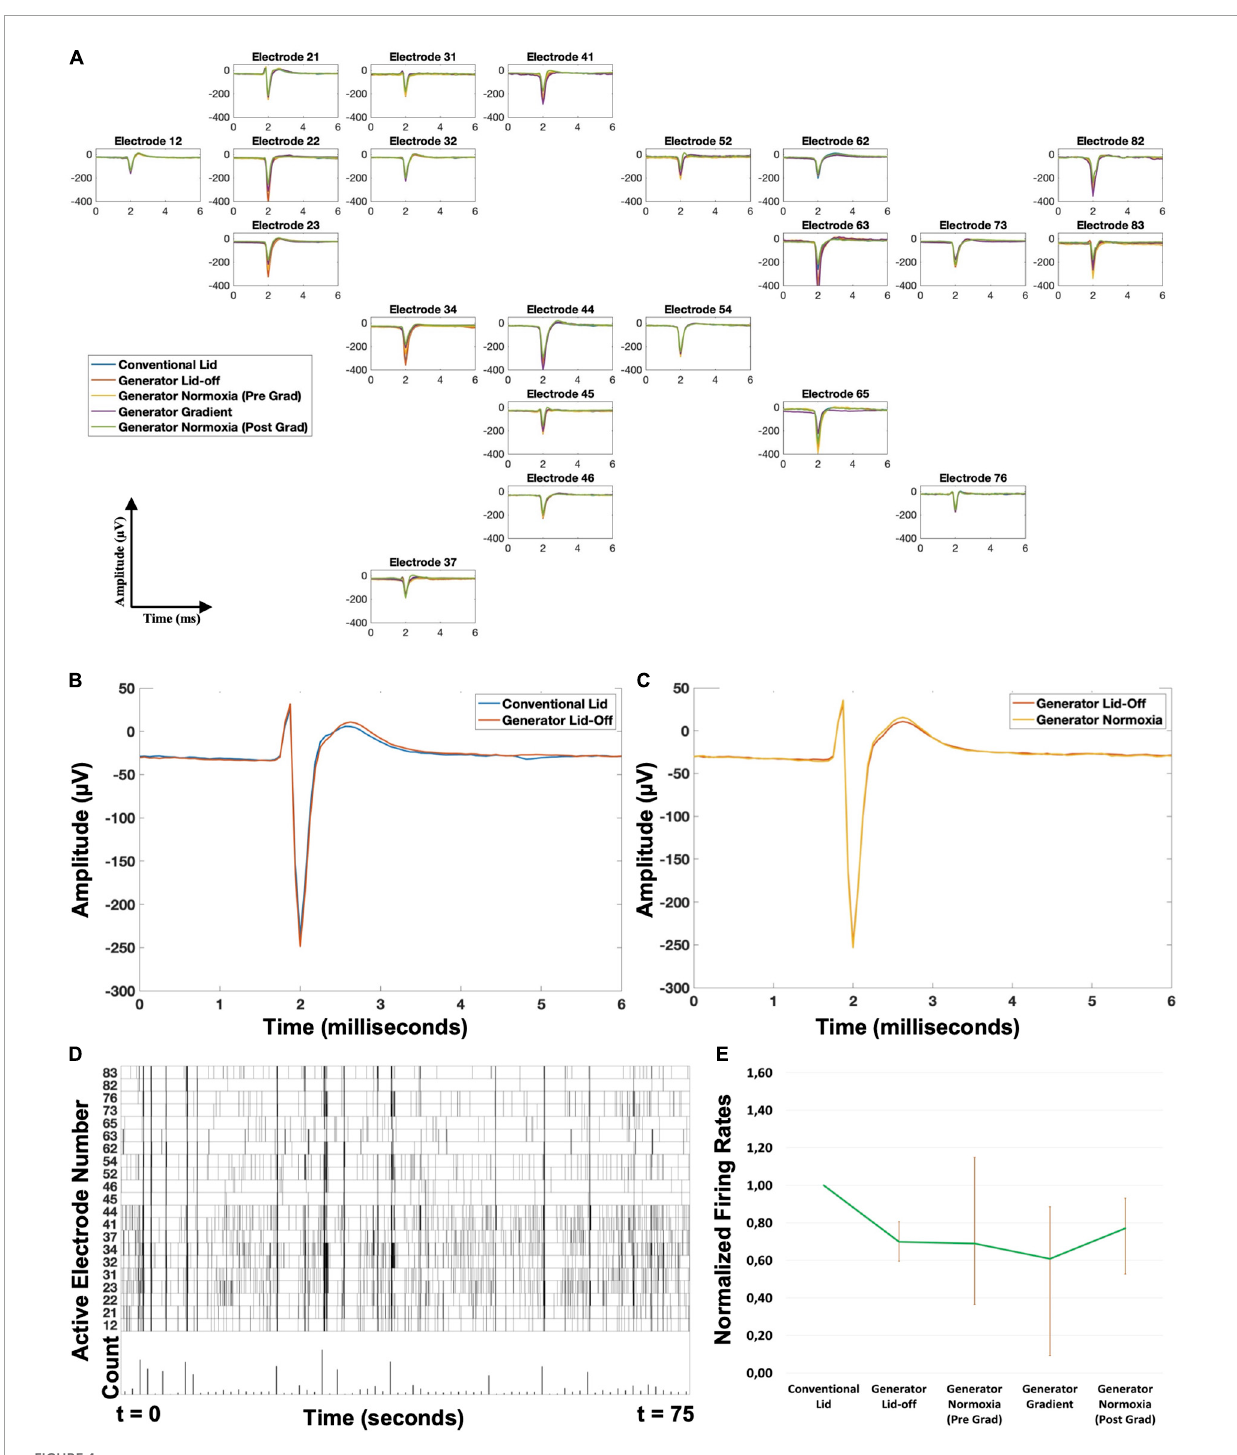
FIGURE4 Electrophysiological recording (A) example of recorded action potentials during the various phases in one experiment, where 21 of the 60 electrodes recorded activity. Position in the figure represents the position of recording electrodes in the Microelectrode Array. Mean waveform of action potentials (shape and amplitude) did not significantly change between phases. (B) Close up of a representative electrode showing the similarities in mean waveform between the phases “Conventional Lid” and “Generator Lid-off.” (C) Close up of a representative electrode showing the similarities in mean waveform between the phases “Generator Lid -off” and “Generator Normoxia.” (D) Example of a raster plot (only active electrodes), with instances of network bursts. (E) Evolution of the mean firing rates per minute during the recordings, normalized to “Conventional Lid” values, showing that there is a decrease in the “Generator Lid-off” and “Generator Gradient” phases, both compensated when oxygen flow through the channels is restored (error bars indicate 25–75% quartiles; n = 41 active electrodes from both experiments combined). All phases lasted 1 h, except “Generator Gradient,” which lasted 2